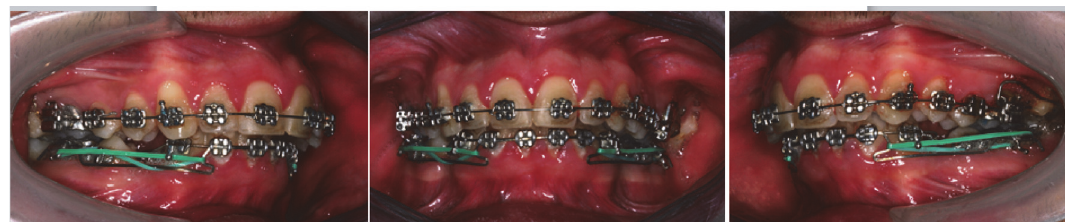
Figure 6: Segmented technique and intra-arch elastics to close extraction space.